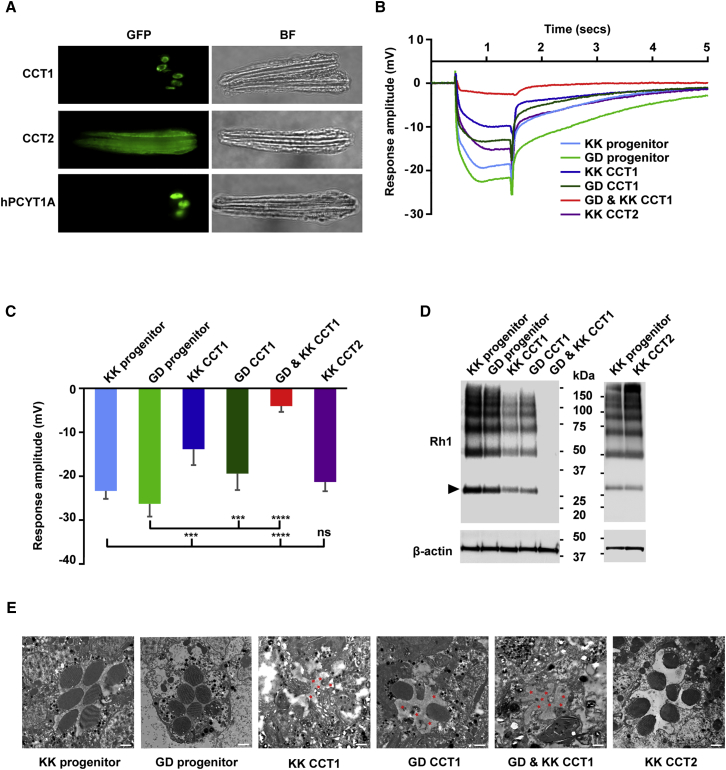
The Fly CCTα Homolog, CCT1, Is Localized within the Nucleus of PRs, and Eye-Specific Knockdown of CCT1 Inhibits Light Response in Flies(A) Individual ommatidia from transgenic flies selectively expressing GFP-tagged fly CCT1, CCT2, or the human CCTα (hPCYT1A) homologs in the retina, under a Rhodopsin (Rh1) promoter, were imaged as described in the STAR Methods. BF, bright-field images. (B–E) Flies with eye-specific single (GD CCT1 or KK CCT1) and double knockdown of CCT1 (GD and KK CCT1) or knockdown of CCT2 (KK CCT2). Flies with no siRNA genes served as negative control (KK/GD progenitor).(B) Response to light activation was assessed by ERG (electroretinogram) scans at increasing intensities of light. Representative traces obtained from a submaximal 1-s flash from a single fly of each genotype are shown.(C) Response amplitude generated in ERG recordings at maximal intensity of light was severely reduced in eyes with CCT1 double knockdown. Data are means ± SD from four to eight flies of each genotype. One-way ANOVA with Bonferroni multiple comparison, ∗∗∗p < 0.001; ∗∗∗∗p < 0.0001.(D) Immunoblotting of lysates from 50 heads of each genotype using rhodopsin antibody; β-actin was used as a loading control. The level of rhodopsin (arrowhead marks mature form) was negligible in flies with CCT1 double knockdown (GD and KK CCT1). Blot shown is representative from three independent batches.(E) Rhabdomere ultrastructure was analyzed by transmission electron microscopy. Cross-sections show normal rhabdomere stacks in the control and CCT2 knockdown flies, while the rhabdomere stacks were loosely stacked or completely absent (red stars) in the CCT1 knockdown flies. Scale bars, 500 nm.See Figure S2.